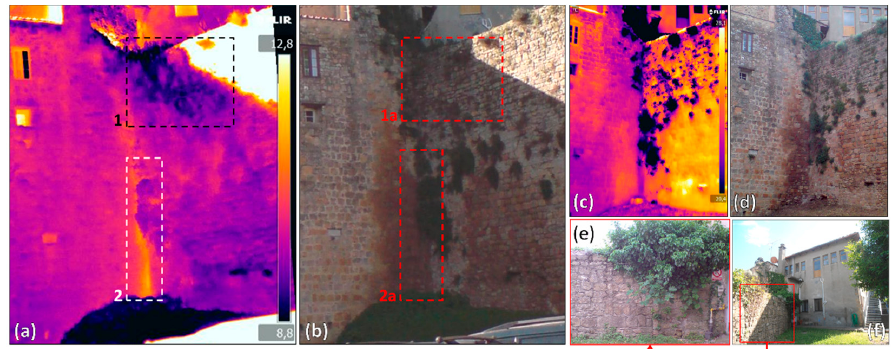
Figure 11. ( a ) Mosaicked thermograms of the northwestern wall sector along Lungomura Vallebona (label 3 in Figure 9a), acquired on 2 December 2015 and correspondent photo; ( b ) Dashed squares 1 and 2 respectively highlight the detected cold and warm thermal anomalies, while dashed squares 1a and 2a enhance the correspondent sectors on the photo; ( c ) Mosaicked thermograms acquired during the 25 May 2015 survey and correspondent photo ( d ); ( e , f ) Back portion of the investigated wall sector were the cold thermal anomaly was detected (red square highlights the location of a primary school building water plant).